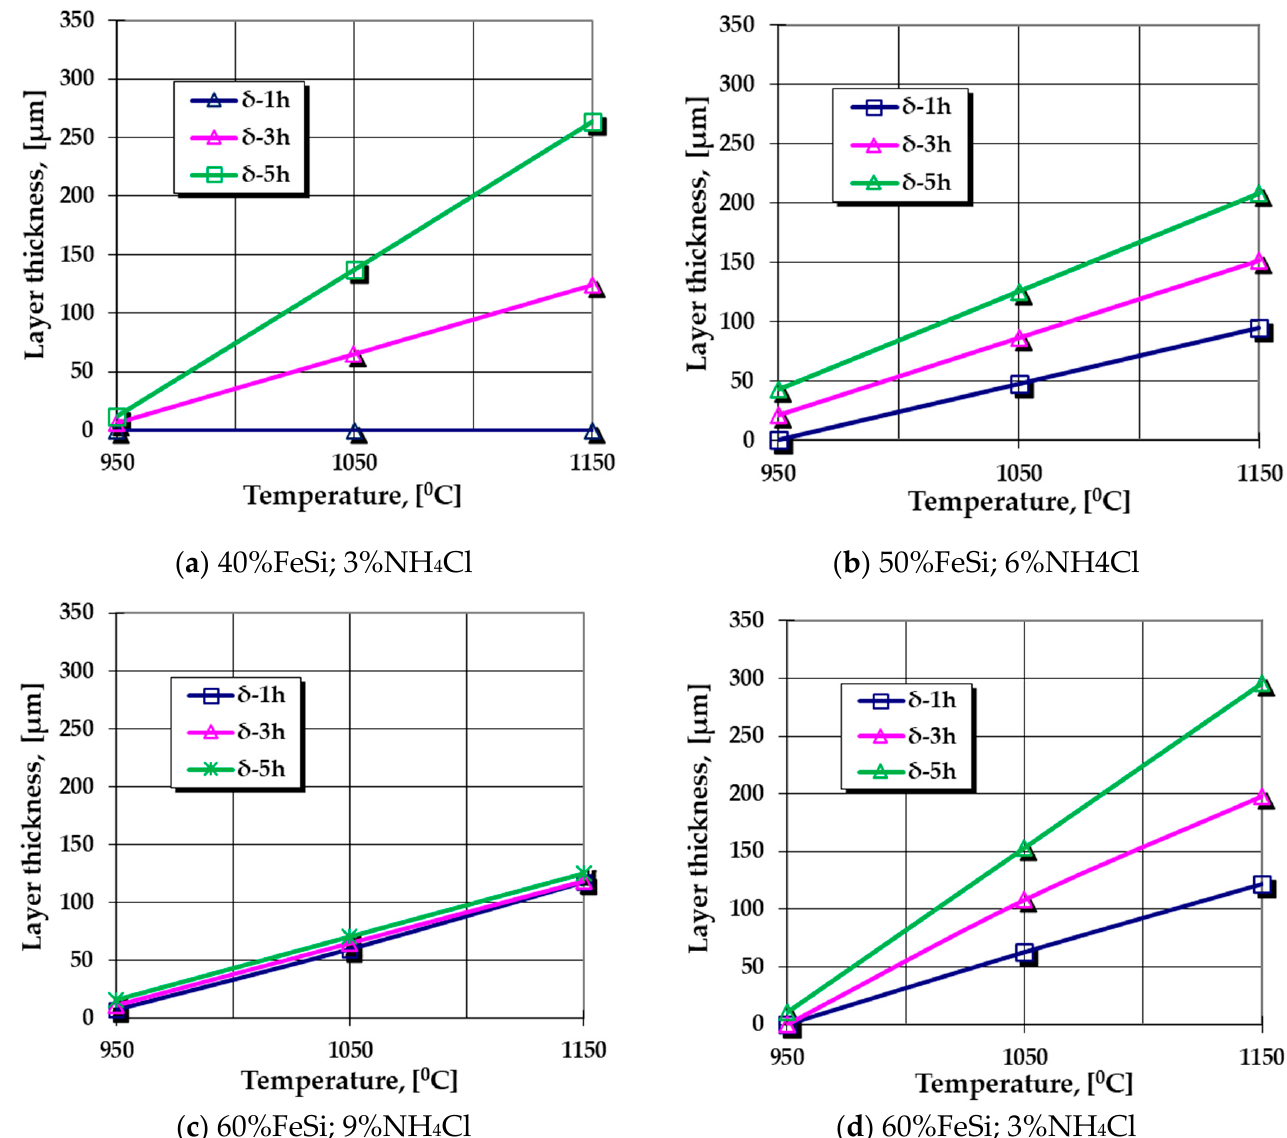
Figure 2. The change in the growth kinetics of the silicon cemented layer (dense and adherent zone) generated by the variation of temperature, the holding time on temperature, and the proportion of ferrosilicon (FeSi75C), namely the proportion of ammonia chloride in the solid powdered mixture utilized.